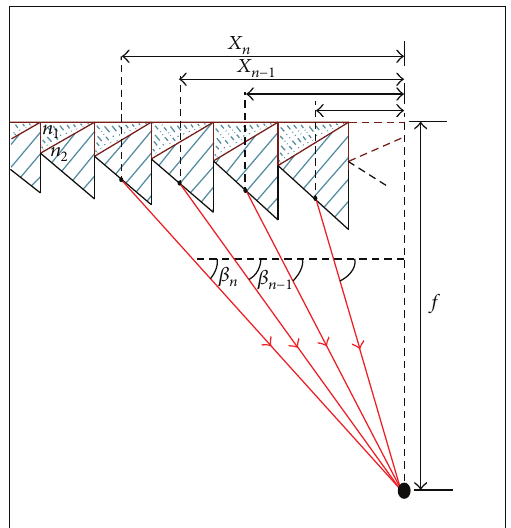
Figure 5: Output angle